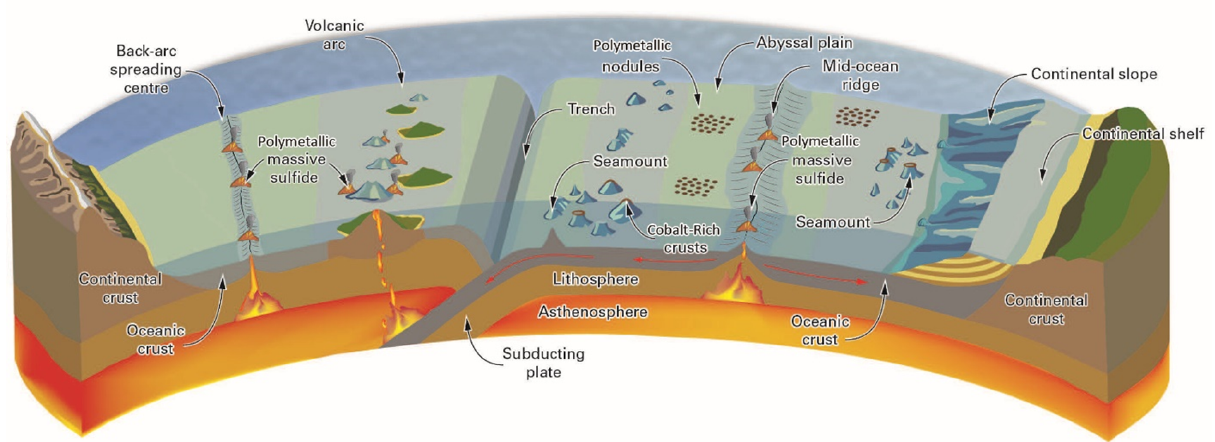
Figure 4. A cross-section through the Earth’s crust and the distribution of the major metal-rich deep-ocean mineral deposits on different types of plate boundary